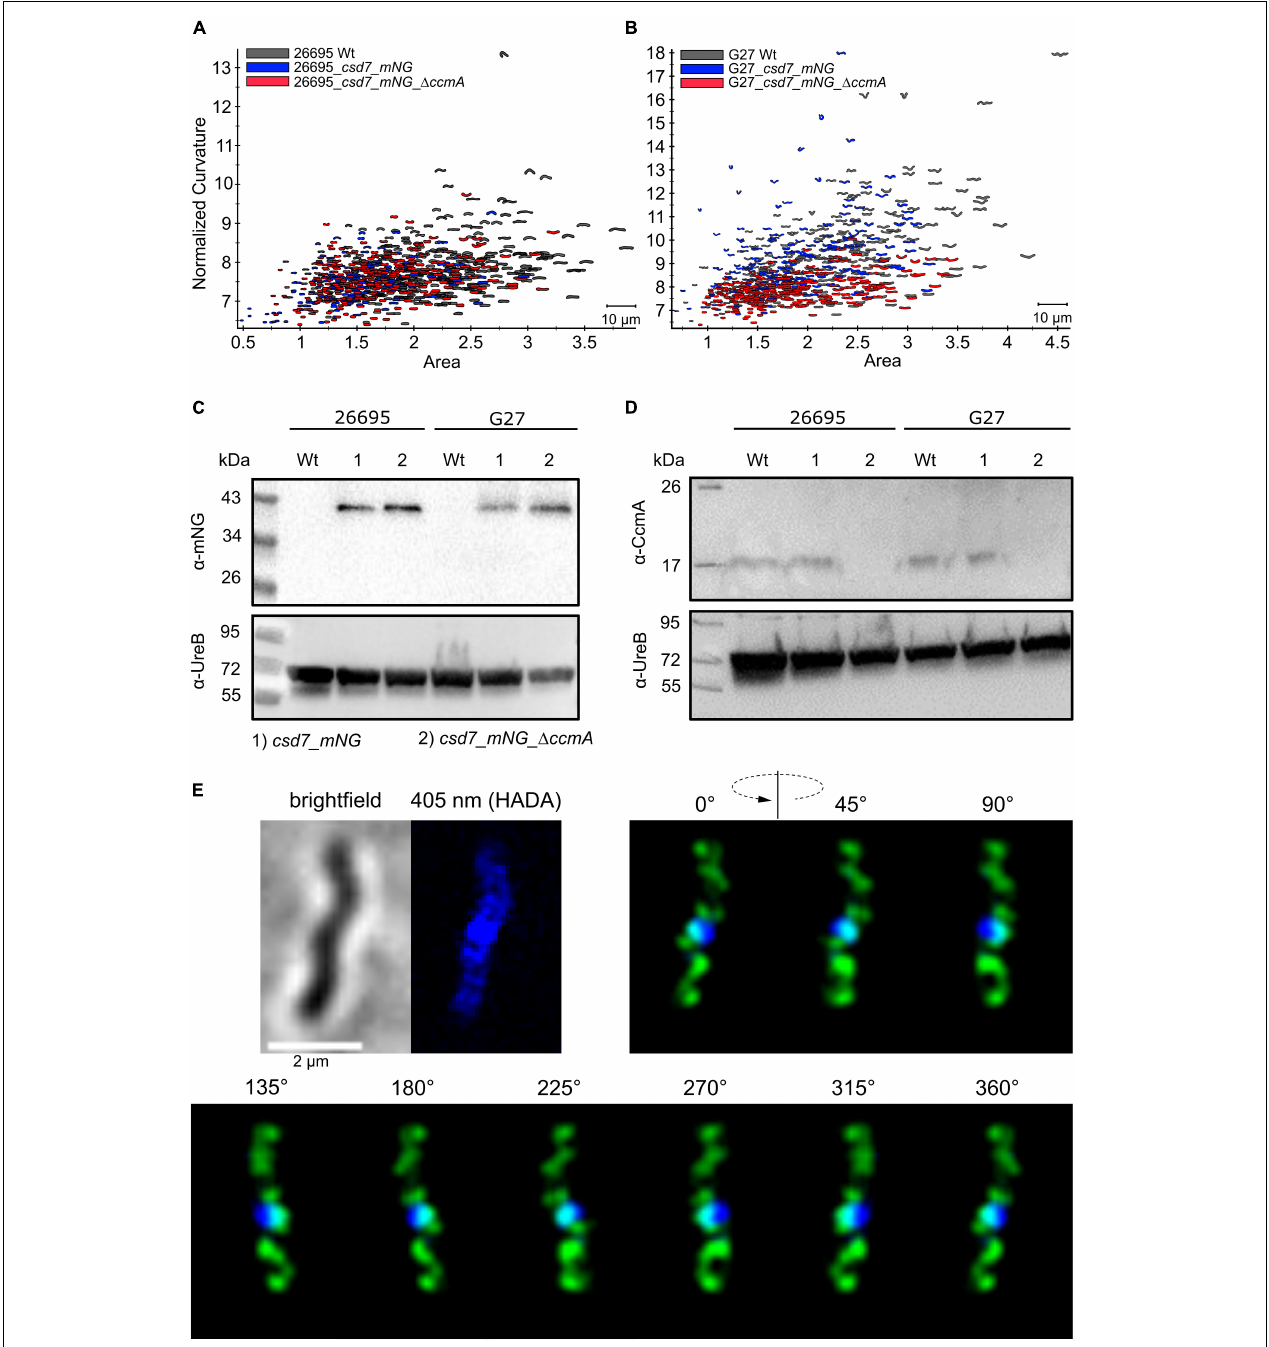
FIGURE 5 | (A,B) Morphological comparison of the wild-type strains (26695, G27-gray) to the respective csd7 _ mNG (blue) strains and their bactofilin knockout variants (red) by principal component analysis. Cells are illustrated in a scatterplot according to their length ( x -axis) and side curvature ( y -axis). G27 wild-type, n = 253; G27_ csd7 _ mNG , n = 251; G27_ csd7_mNG_ (cid:49) ccmA , n = 258; 26695 wild-type, n = 278; 26695_ csd7_mNG , n = 272; 26695_ csd7_mNG_ (cid:49) ccmA , n = 270. Western blot depicting stable fluorescent fusions of mNG with Csd7 in 26695 and G27 (C) and verifies the correct bactofilin deletion in Csd7_mNG strains (D) . The usage of urease B-antibody functions as a loading control for each western blot. (E) Structured illumination microscopy of the Csd7_mNG fusion protein in H. pylori G27. Exemplary cell with Csd7_mNG (green) and newly incorporated peptidoglycan visualized by pulse labeling (20 min) with HADA (blue). Cells were acquired via Z-stack and projected to a 3D-image. Montage shows cells from different angles. Csd7_mNG fusion forms membrane-associated filamentous structures along with the cell. Scale bar = 2 µ m.